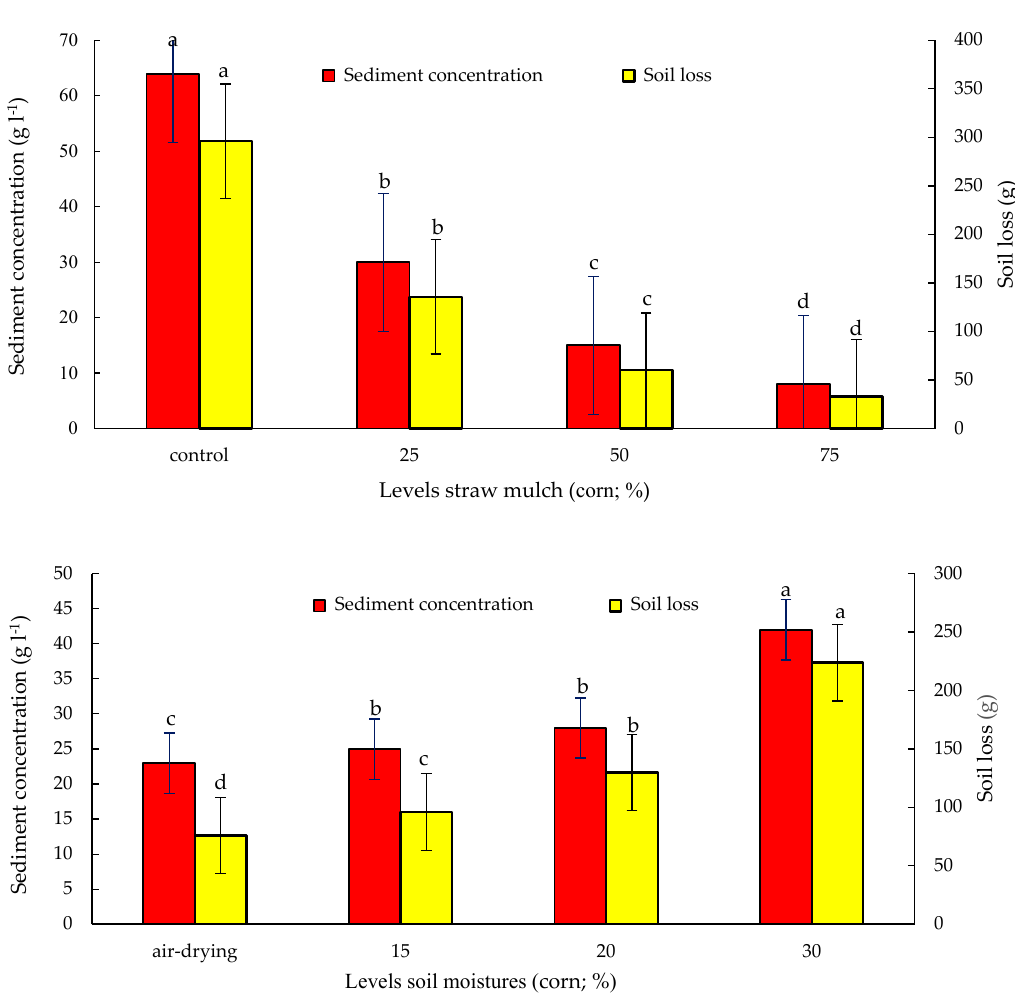
Figure 5. Comparison of soil loss and sediment concentration at different levels of colza straw mulch (above) and soil moisture conditions (below), based on the Duncan test.